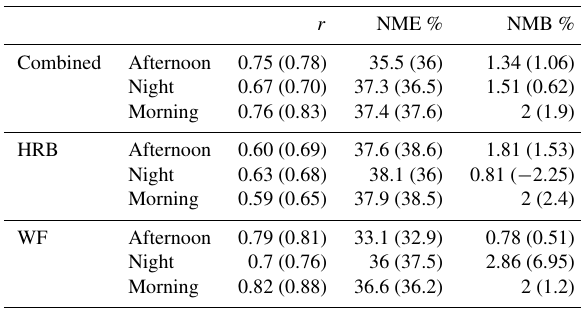
Table 2. Accuracy statistics from random forest modelling for train- ing and test (in brackets) sets. Training set predictions are on out-of- bag samples during model fitting, and test set predictions were made on the independent test set. Overall statistics, along with statistics on HRB and WF portions of the data, are shown. r , Pearson corre- lation; NME, normalised mean error; NMB, normalised mean bias (Emery et al.,